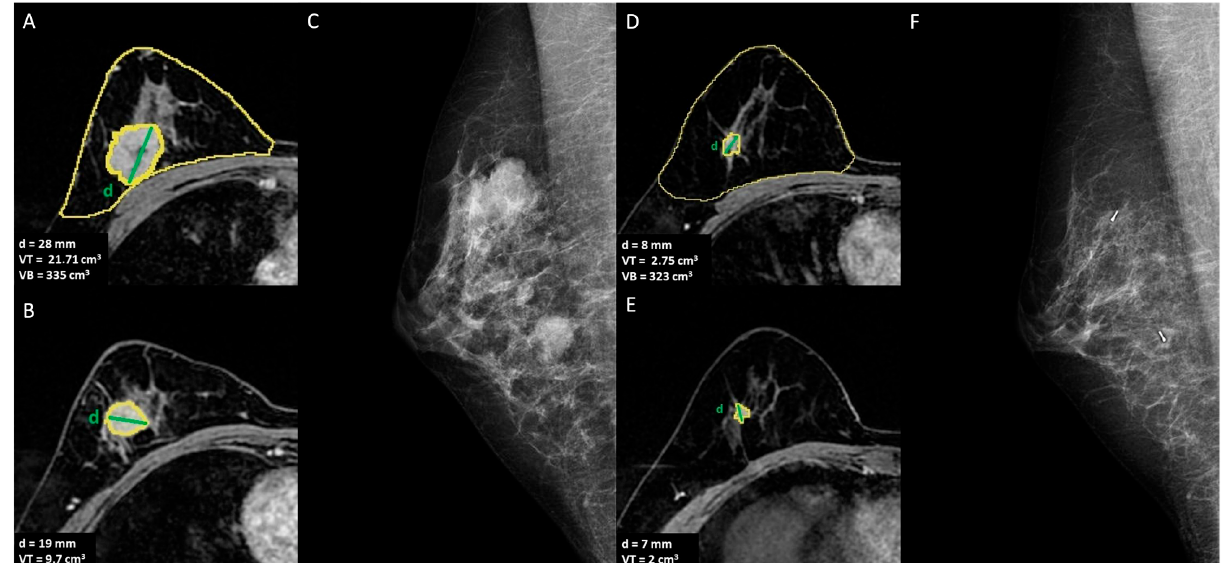
Figure 2. A 42-year-old women with multicentric invasive TN ductal carcinoma with indication of mastectomy after NACT: ( A , B ) T1-weighted post-contrast MRI to define the extension of the disease and breast volume, VB = breast volume, VT = tumor volume, d = diameter of the lesion; ( C ) mediolateral oblique mammogram shows the two lesions, ( D , E ) T1-weighted post-contrast MRI to assess the response to NACT, ( F ) mediolateral oblique mammogram of the two lesions